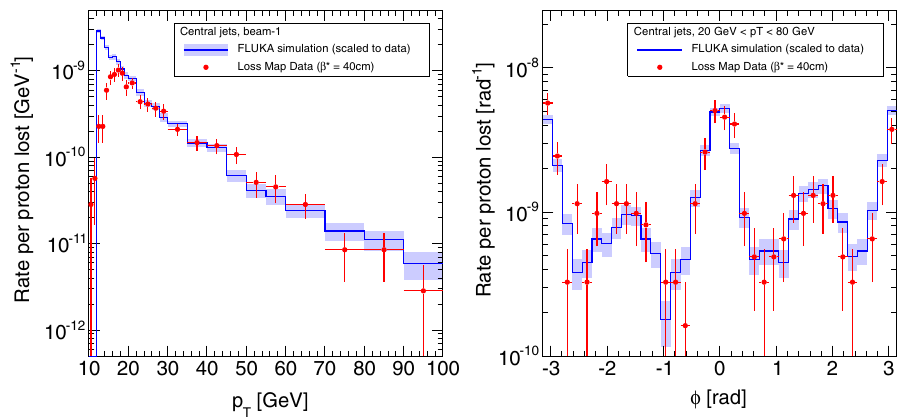
FIG. 13. Comparison of simulated p and azimuthal distributions of fake jets with data for B1 losses at β (cid:1) ¼ 40 cm and a TCT T aperture of 8 . 8 σ . In both plots only jets in the central barrel calorimeters are considered. For the ϕ distributions an additional requirement > 20 GeV has been applied in order to stay in the region where the ATLAS jet trigger is fully efficient. The azimuthal angle ( ϕ ) is of p T measured with respect to the x axis, which in the ATLAS coordinate system points towards the center of the LHC ring. Only the statistical uncertainties of the simulations and the data are indicated. The data and simulations are taken from [24] but have been rebinned into a wider structure at large p where statistics is poor. In order to facilitate the shape comparison, the simulation results have T been scaled to the data using the ratios given in Table